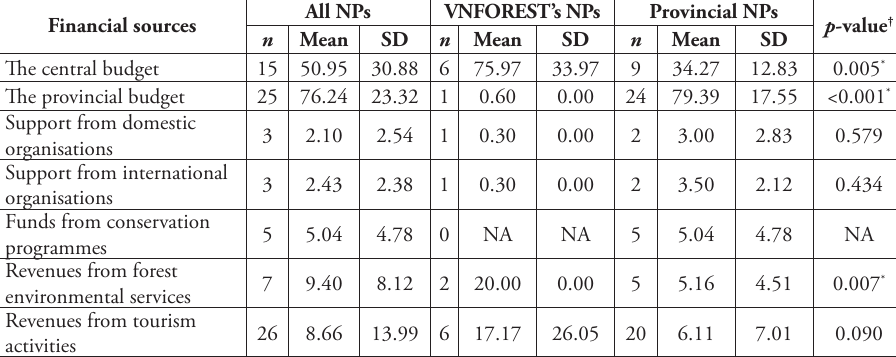
Table 3. Percentages of financial sources of the total funding for national parks.